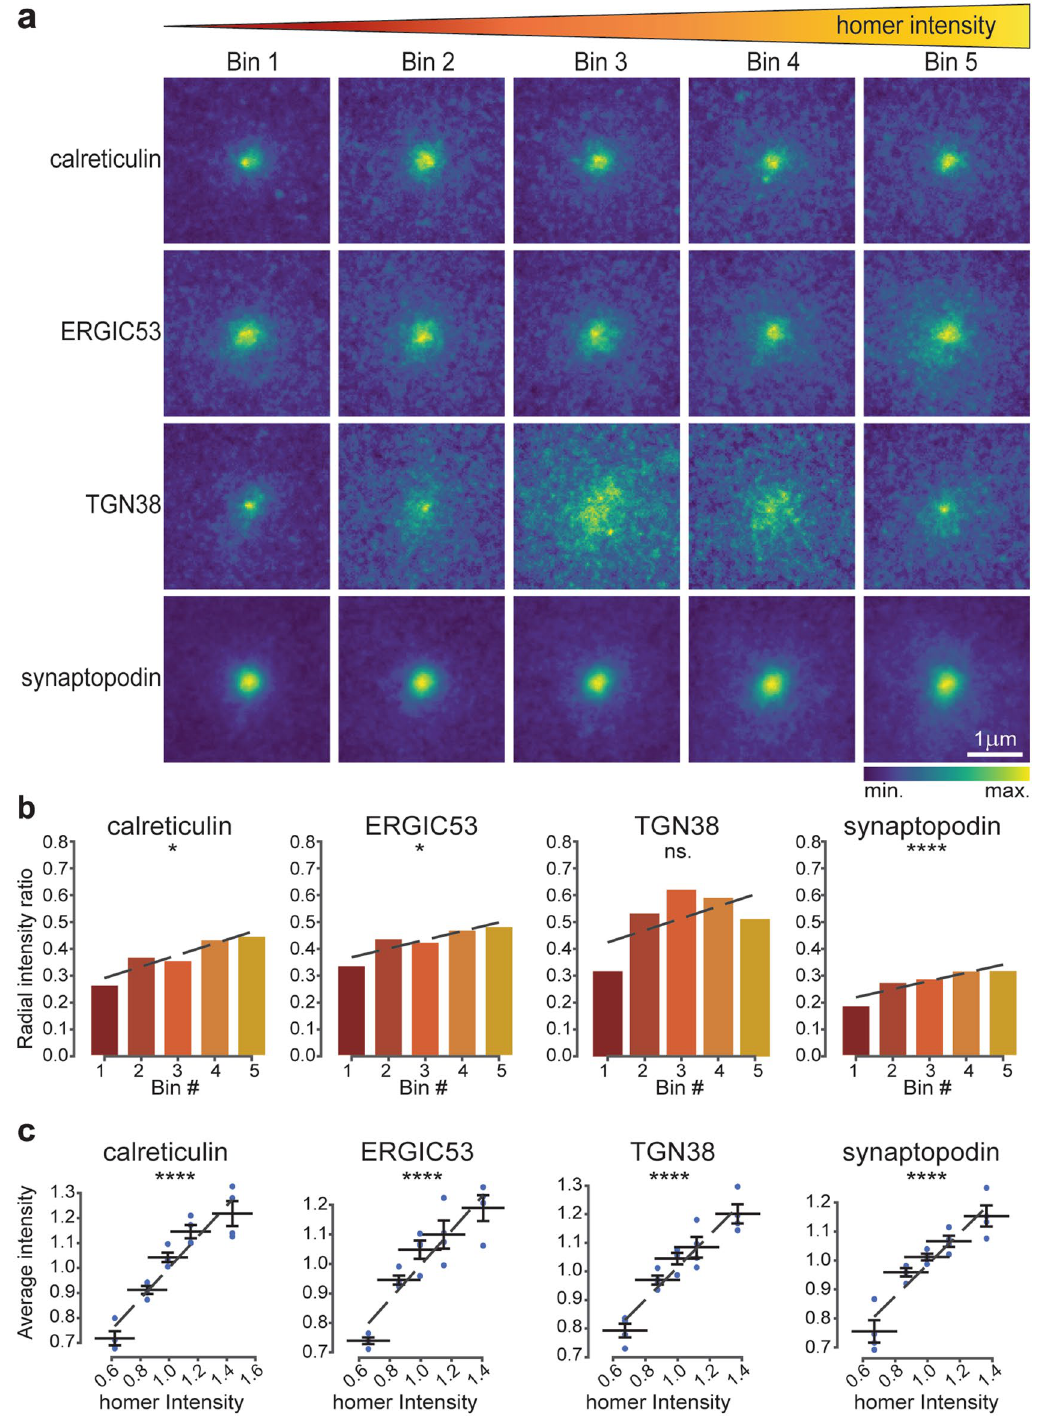
Figure 2. Correlation between post-synaptic strength and secretory pathway elements. ( a ) Average images for the different POIs based on five homer intensity bins displayed in 3 × 3 µm crops around the synaptic site. Bin 1 has the lowest homer intensity and bin 5 the highest. ( b ) Ratio between signal intensity at the periphery and at the centre of the average images, calculated by radial analysis. ( c ) Correlation of homer intensities and the average intensities of the POIs. Dashed lines are linear fits. All data were collected from four independent experiments. * = p < 0.05, ** = p < 0.01, *** = p < 0.001, **** = p < 0.0001, and ns. = non-significant. Whiskers represent S.E.M. Number of synapses per bin and Spearman’s rho are listed in Supplementary Table